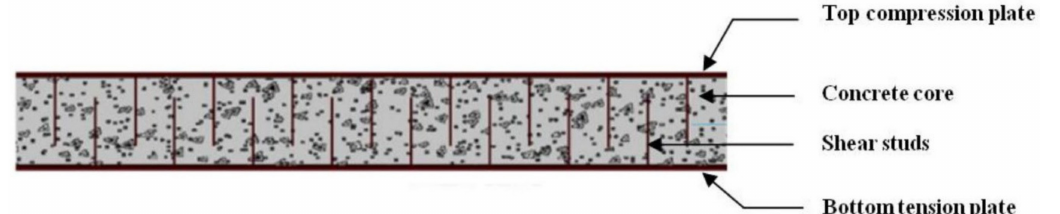
Figure 1. Illustration of typical steel-concrete-steel sandwich beam.